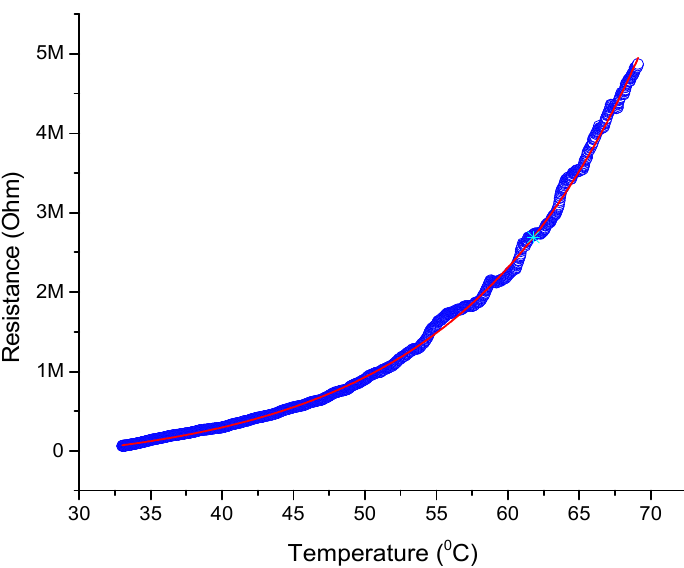
Figure 8. Resistance of the fabricated silver nanofibers sensor vs. temperature.